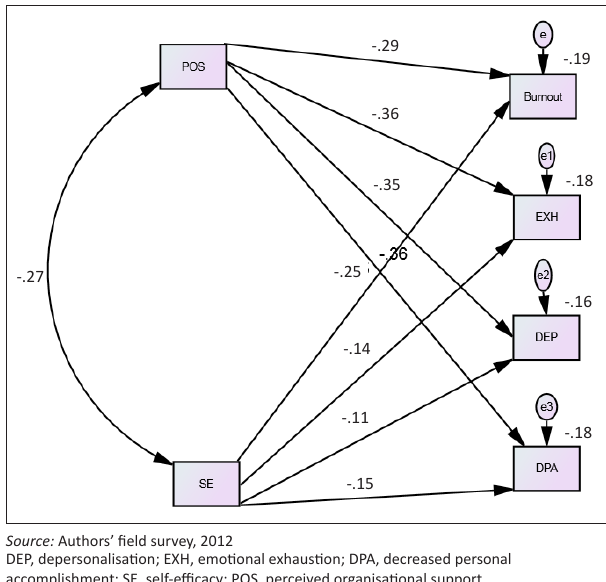
FIGURE 1: Paths between psycho-organisational variables and job